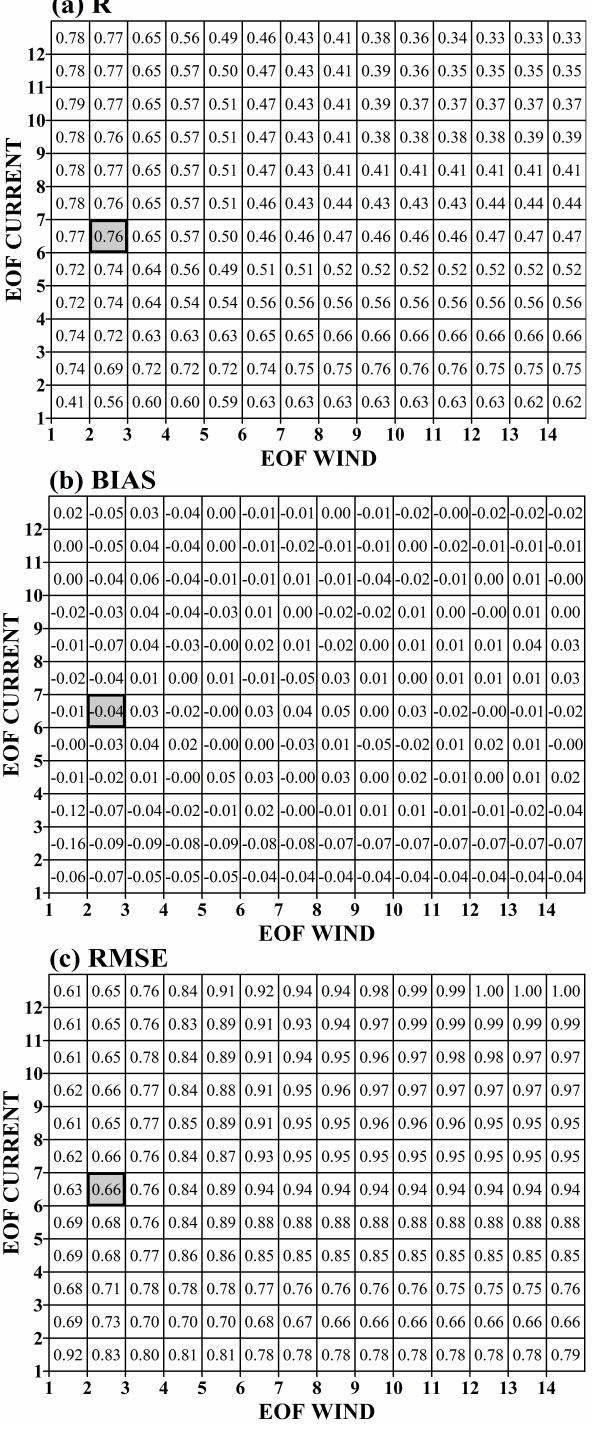
Fig. 4. Selection of the optimal CCA model for the D1 spatial do- main by means of cross validation: (a) correlation coefficient ( R ), (b) bias and (c) root mean square error